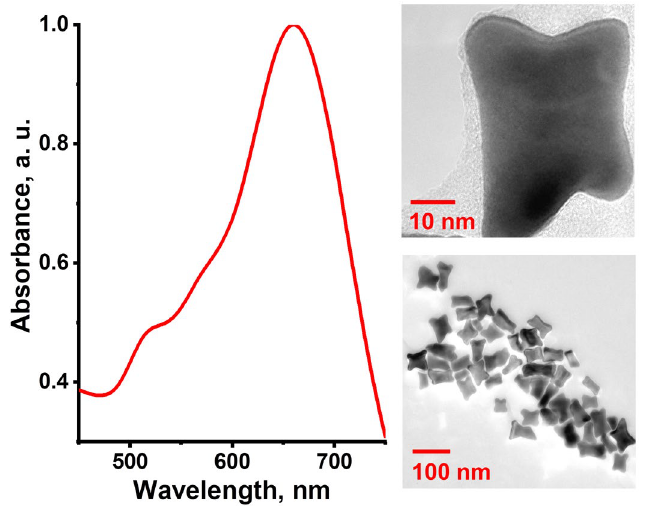
Figure 2. UV-Vis absorption spectrum and TEM images of bone-shaped gold